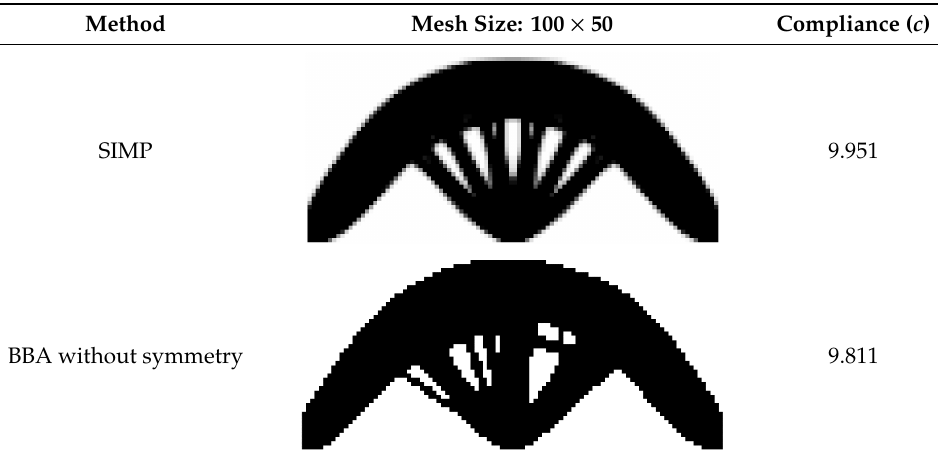
Table 4. Comparison of the best topologies of the pinned-pined plate.